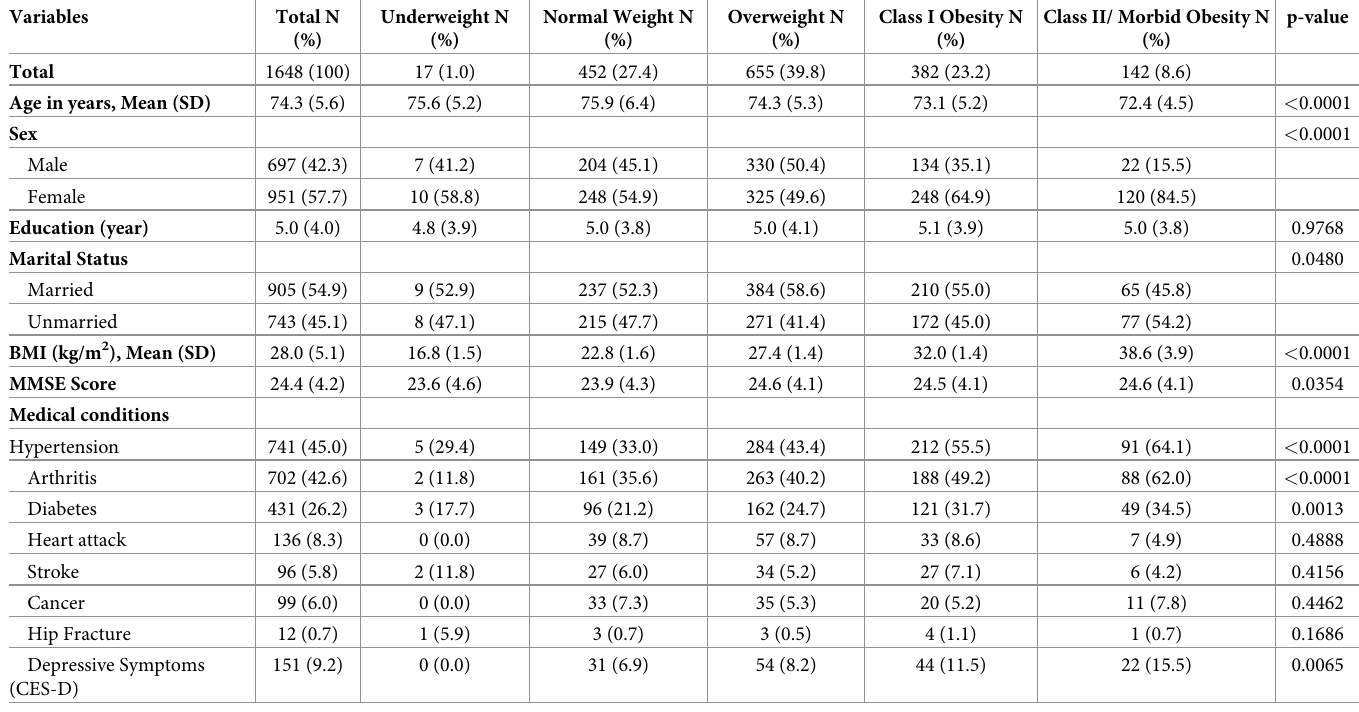
Table 1. Sample characteristicsof non-frail older Mexican Americans by BMI categories at baseline (N =